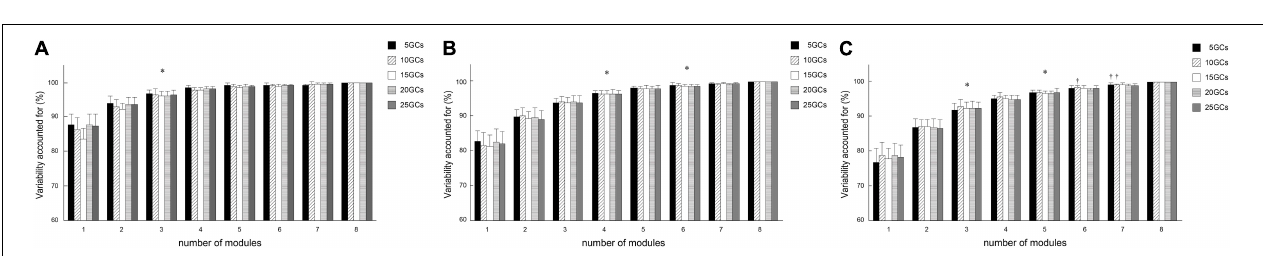
FIGURE 3 | Effects of different conditions on total variability accounted for. Effects of different GCs when the LPFs were 4 Hz (A) , 10 Hz (B) , and 15 Hz (C) . The bars of total variability accounted for indicating the conditional median, and the error bars indicate the median absolute deviations. Significant differences are marked with ∗ ( p < 0.05 in the Friedman test only) and † ( p < 0.05 in the Friedman test, and p < 0.0125 when comparing the reference condition, 25 GCs, or p < 0.016 when comparing between LPFs in the Bonferroni-corrected Wilcoxon signed-rank sum test). LPF, low-pass filter; GC, gait cycle.